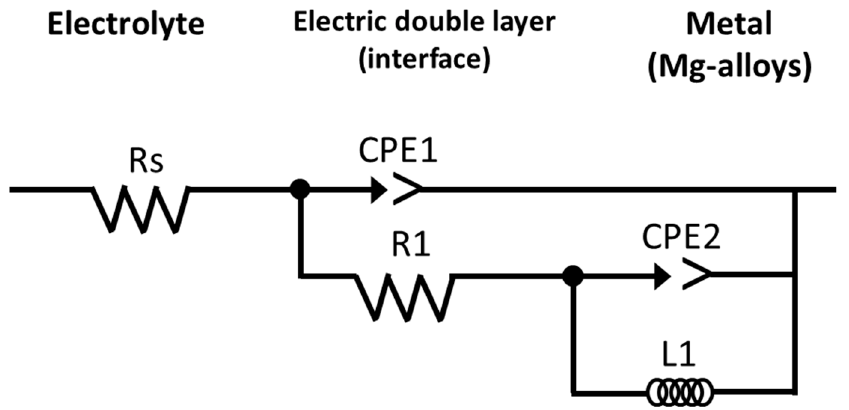
Figure 12. Equivalent electric circuit used to fit the EIS spectra of the Mg ‐ anodes immersed in sea ‐ water.